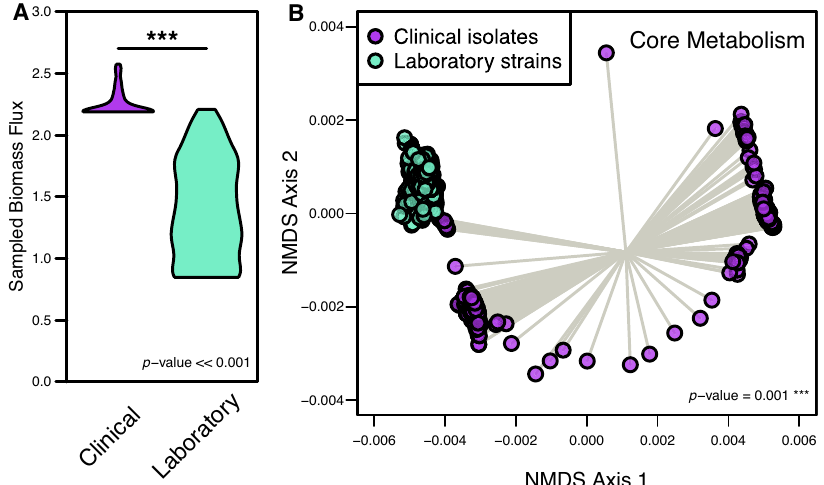
Fig. 4 Growth rates and core metabolic activity signi fi cantly differ between clinical and laboratory isolate context-speci fi c models. A Distribution of biomass synthesis reaction fl ux in each context-speci fi c model, which relates to optimal growth rates. Signi fi cant difference determined by Wilcoxon rank-sum test. B Non-metric multidimensional scaling (NMDS) of Bray – Curtis dissimilarity between sampled context- speci fi c fl ux distributions from infection and in vitro growth. Each point represents the collective activity of all reactions in a context-speci fi c model during optimal growth conditions. Signi fi cant difference determined by